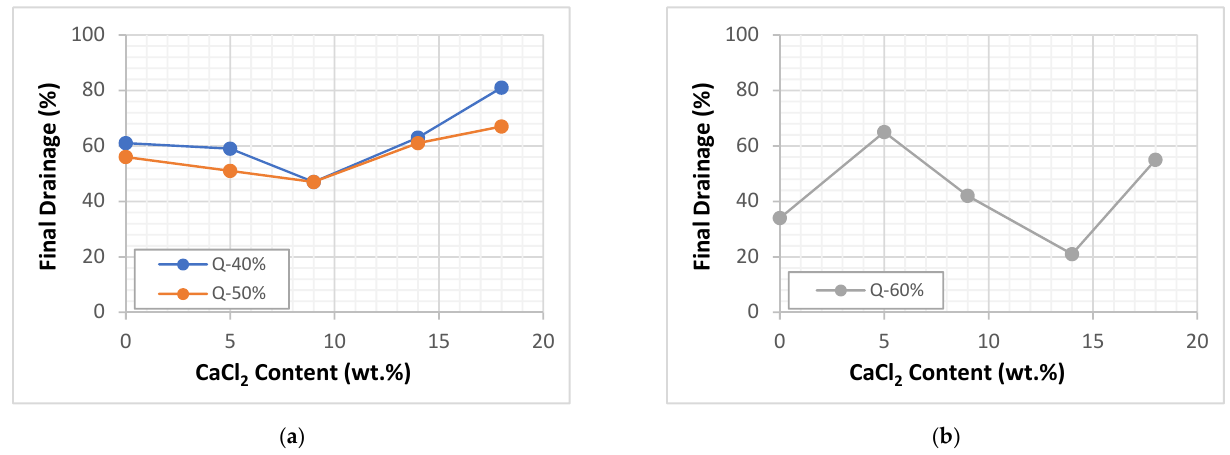
Figure 10. Final average drainage (AVE) vs. CaCl 2 content for different foams: ( a ) 40% and 50%, and ( b ) 60%.